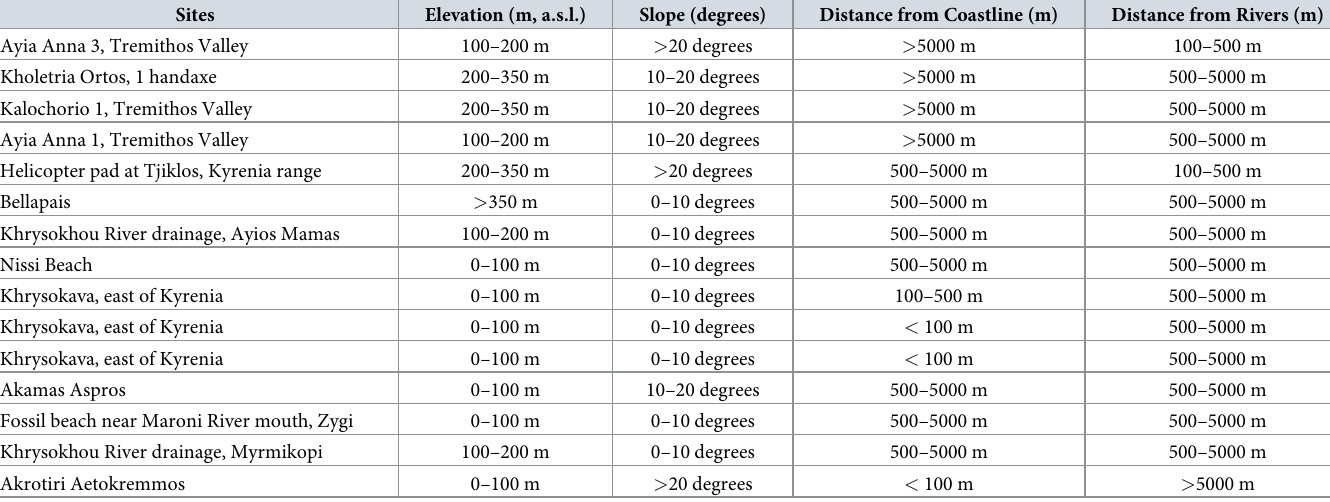
Table 1. Main topographic features of Terminal Pleistocene and legacy Palaeolithic surface lithic assemblages from Cyprus.